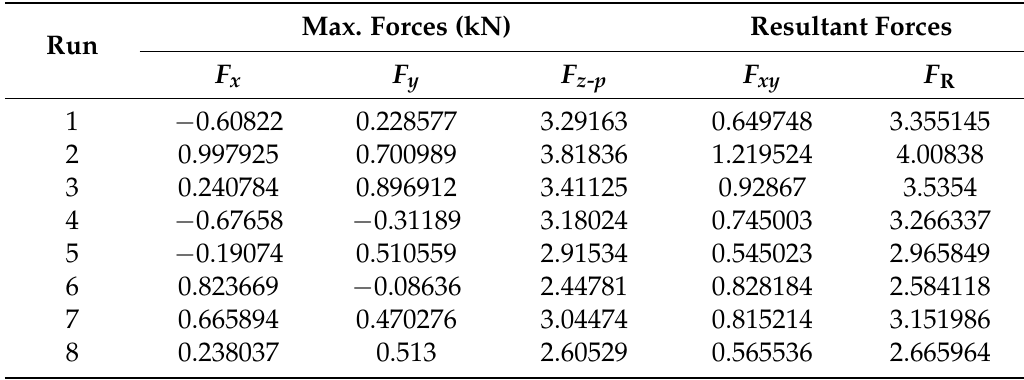
Table 4. Forming forces in x , y , and z directions and the resultant forces at the peak